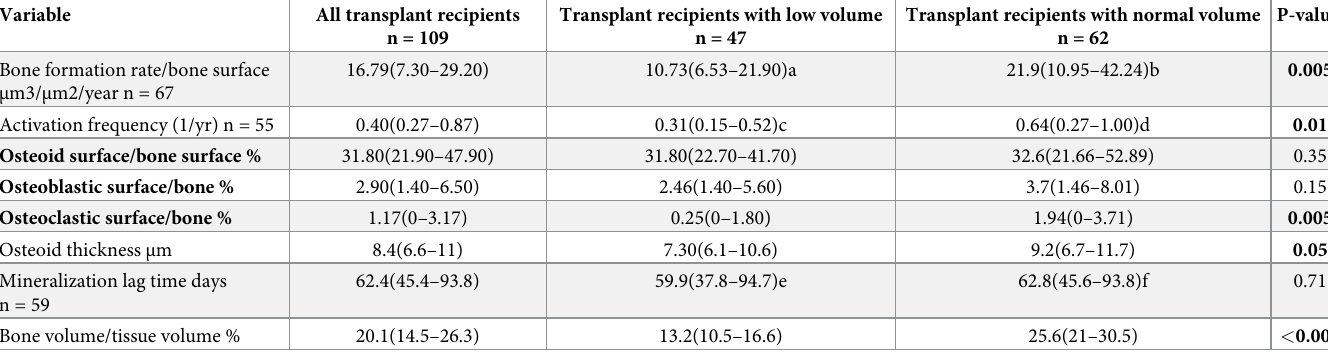
Table 4. Bone histomorphometric parameters in transplant recipients with and without low